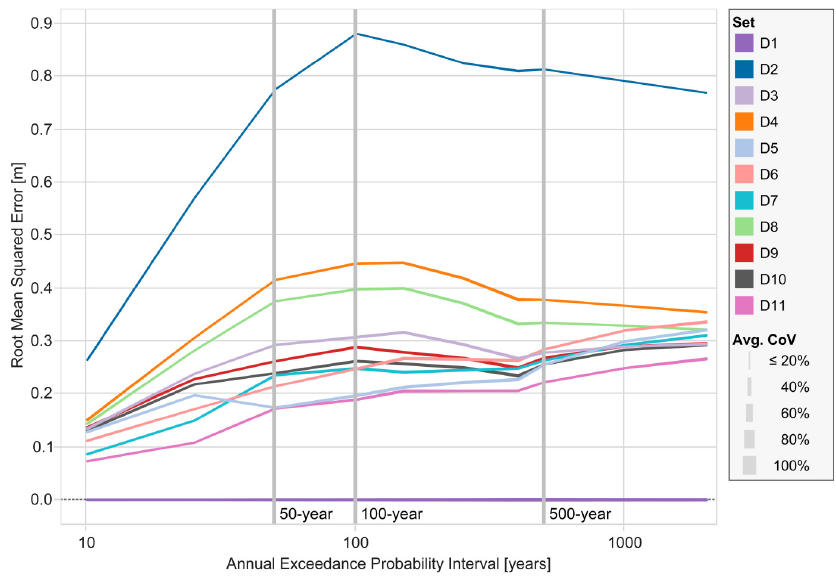
Figure 8. Average bias and variance by exceedance interval (unenclosed points only).